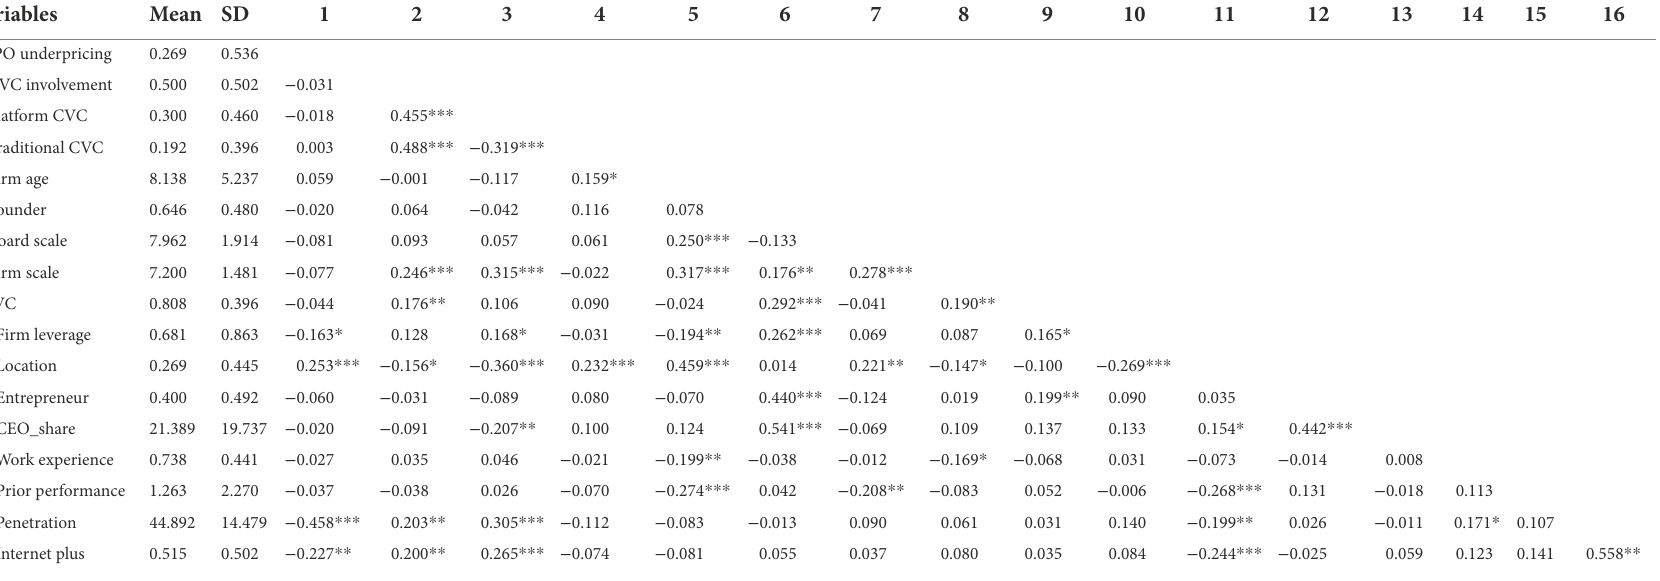
TABLE 2 Descriptive statistics and